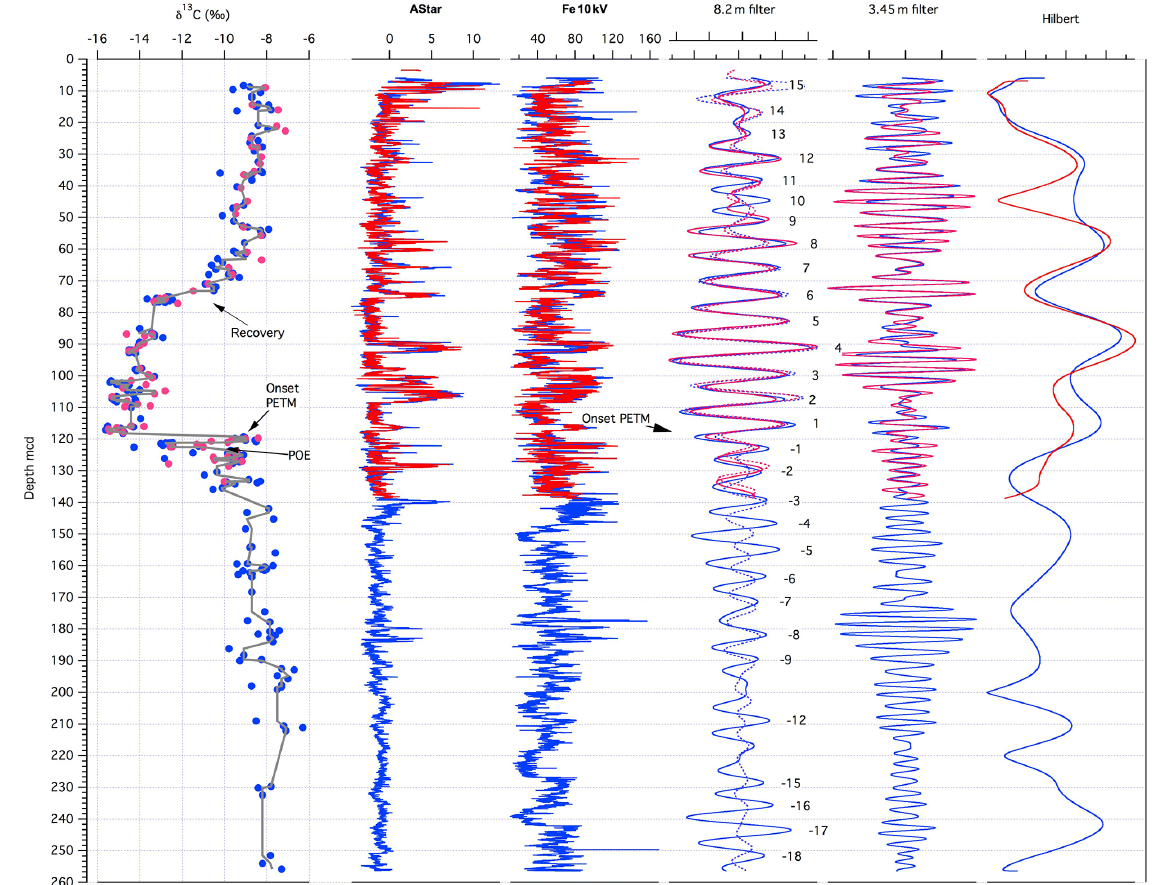
Figure 5. Cyclostratigraphy for Polecat Bench. From left to right: PCB-A (red) and PCB-B (blue) soil nodule carbon isotope data (Bowen et al., 2015), a ∗ data from color scanning, and XRF Fe intensity data (in total counts area · 1000). The Gaussian filter of the longer 8.2m cycle (precession) of the Fe data (solid lines) and from a ∗ data (dashed lines). Numbers mark the precession cycle counting starting at the onset of the PETM; positive numbers are time after PETM, negative numbers before. On the right is a Gaussian filter of the 3.5m cycle (half precession) and the amplitude modulation of the Fe data extracted with Hilbert transform using the “astrochron” software package (Meyers,